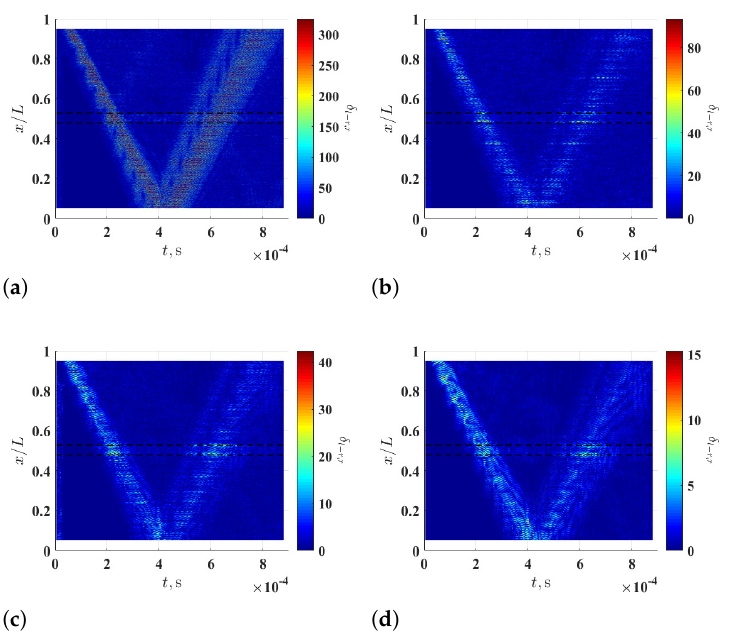
Figure 10. Multi-resolution local-regression TSCDI δ l − r , r associated with the measured wave of the damaged beam with ( a ) r = 1, ( b ) r = 8, ( c ) r = 16 and ( d ) r = 32 and ξ = 10%. Locality and extent of the damage are indicated by two dashed lines.